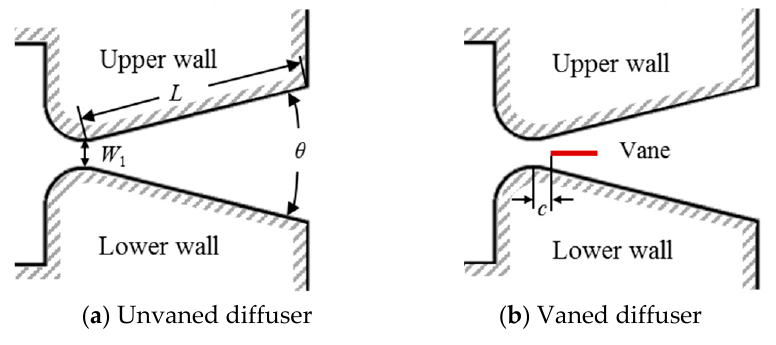
Figure 2. Geometries of test diffusers. Table 1. Major dimensions of test di ff user and